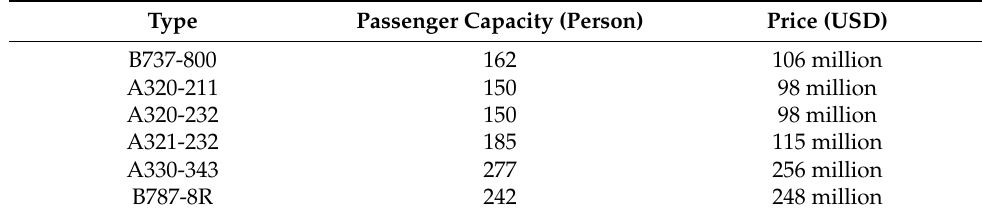
Table 1. Information on the main aircraft types at BIA [30].